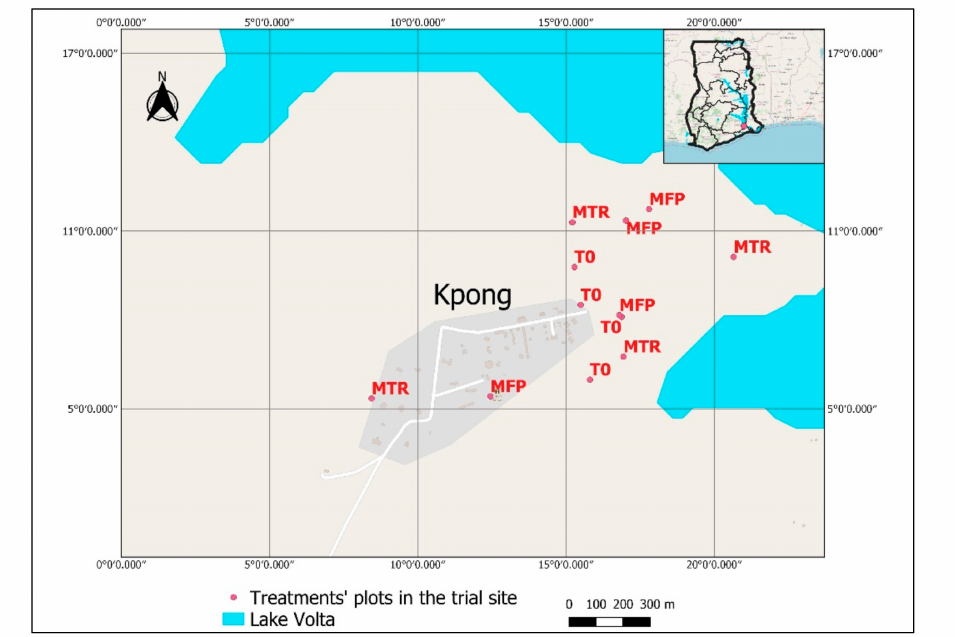
Figure 1. Study site indicating the position of plots for the three treatments: maize plots in which T. remus are released (MTR); maize plots with farmer practice (MFP); untreated control maize plots